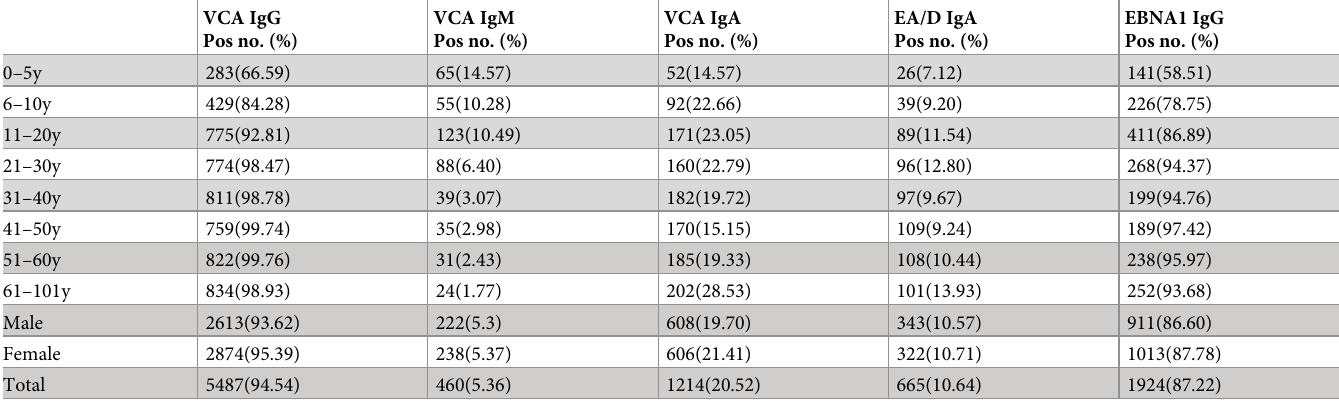
Table 2. Age-related anti-EBV antibodies in all non-nasopharyngeal carcinoma patients visiting the PUMC Hospital, Beijing, 2013–2017. VCA IgG Pos no.